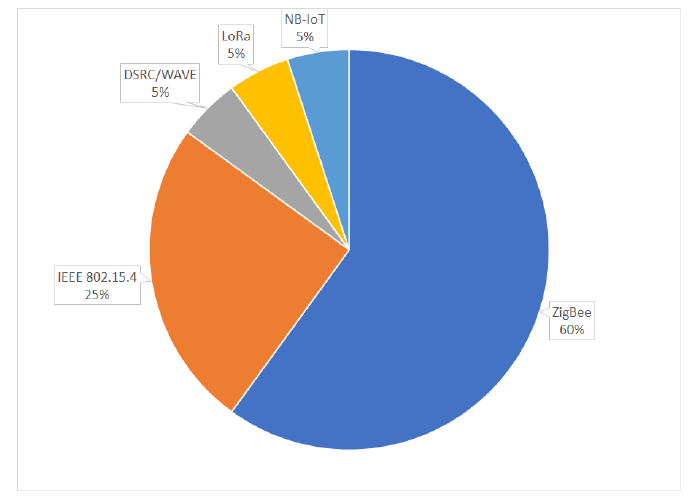
Figure 10. Wireless Internet of Things (IoT) protocol usage distribution.